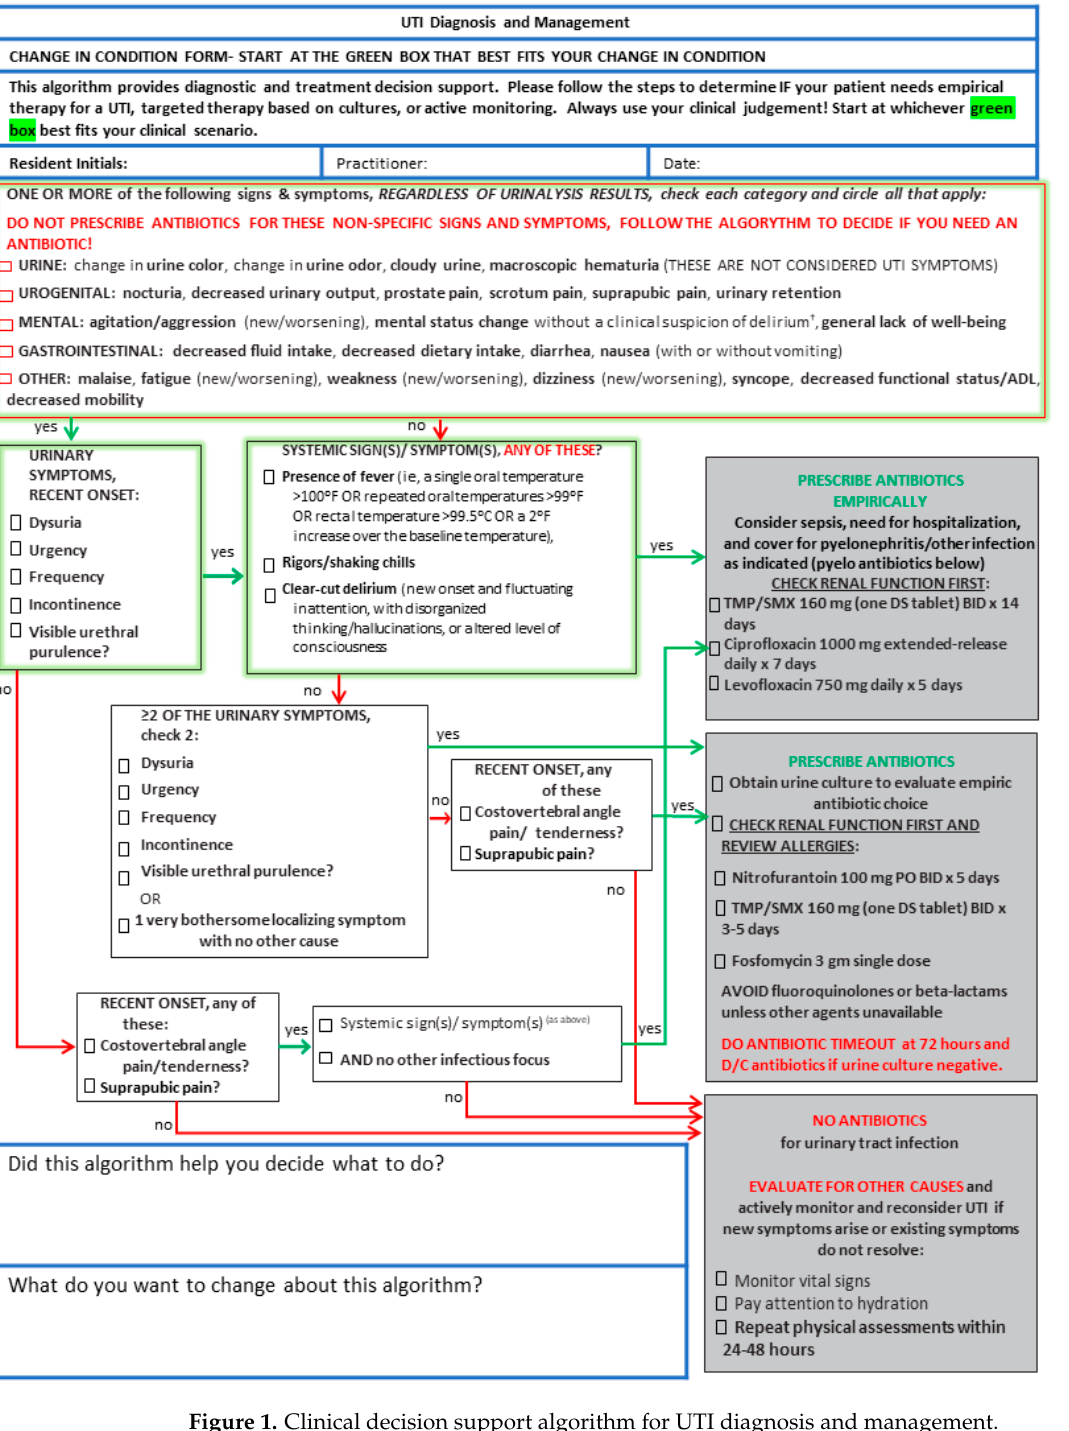
Figure 1. Clinical decision support algorithm for UTI diagnosis and management.